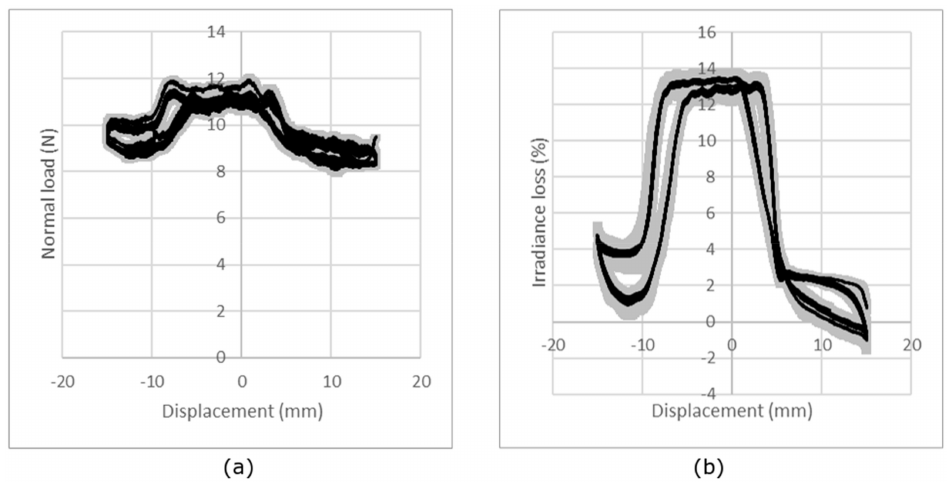
Figure 10. Repeatability of the measurements: ( a ) evolution of the normal force and ( b ) evolution of the loss of irradiance relative to the displacement of the slider for five repetitions of the measurement on the same single jersey sample under a nominal load of 10 N. The black line represents the average curve and the gray area the standard deviation.